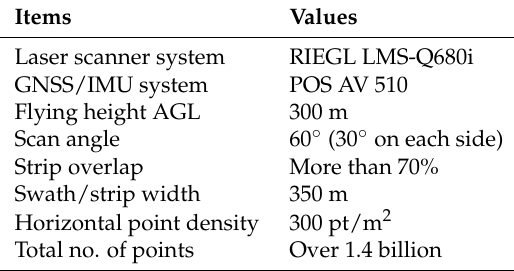
Table 1. Specifications of the Light Detection and Ranging (LiDAR) system and the collected point